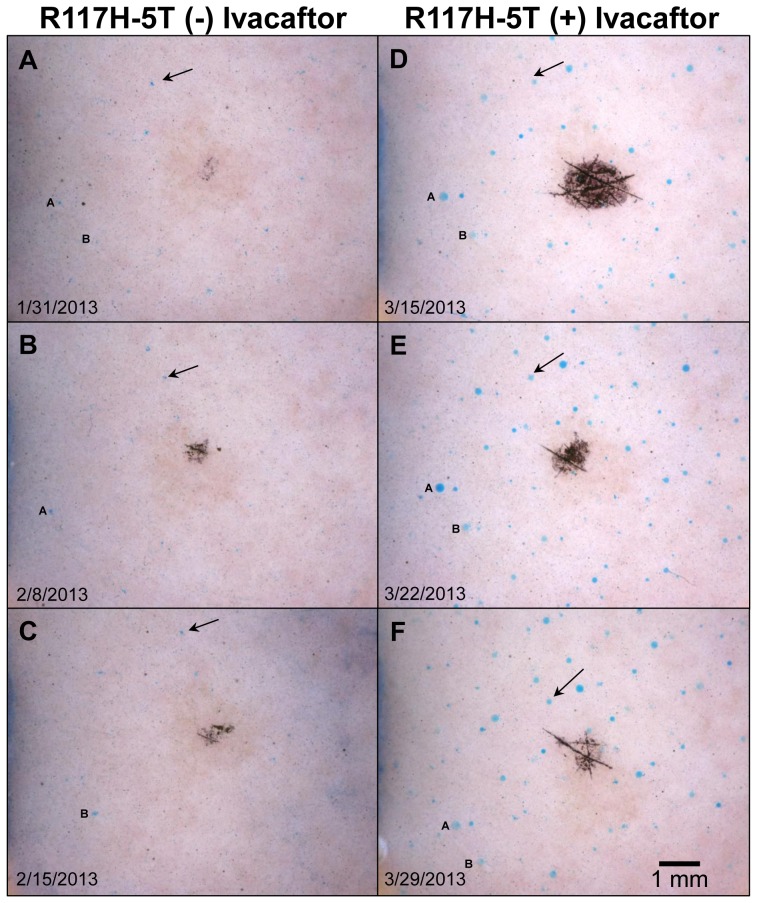
Images of C-sweat responses for CF subject 8: male, I507del/R117H-5T (±) ivacaftor (N of 1 trial).S8 was tested 3 times (−) ivacaftor and 5 times (+) ivacaftor. Only the first 3 (+) ivacaftor tests are shown. (A-C) (−) ivacaftor; (D-F) (+) ivacaftor. Each image shows the field 30 min after the cocktail injection. A light freckle served as the landmark, with an ink spot on the freckle to improve registration and focusing. For image (F) the ink spot was too high causing the field to shift down. In this pancreatic sufficient subject, a few glands marked as A, B, or arrows) produced small amounts of C-sweat (−) ivacaftor.